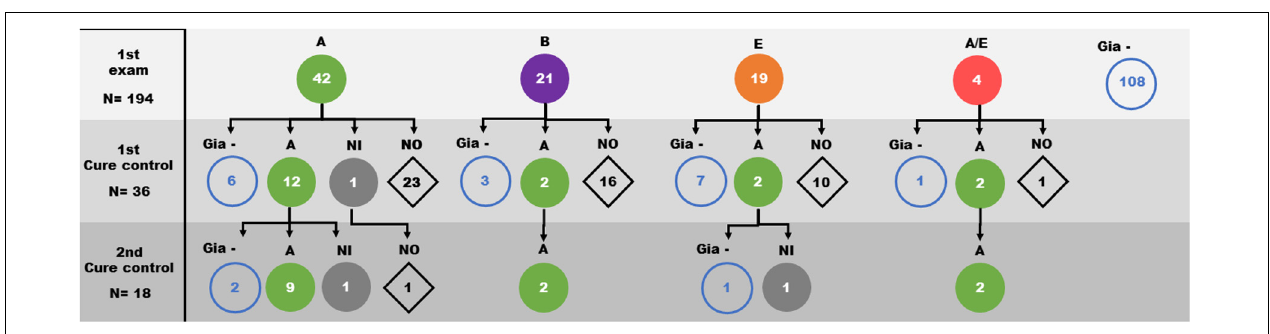
FIGURE 2 | Distribution of Giardia lamblia assemblages (circles) identified in faeces samples from children over the three evaluation moments of the study (1st Giardia PCR sampling, 1st cure control and 2nd cure control). A: Assemblage A ( ); B: Assemblage B ( ); E: Assemblage E ( ); A/E: Assemblage A/E ( ); NI: Assemblage not identified ( ); Gia– : samples with negative PCR to Giardia ( ); NO: sample not obtained ( ).